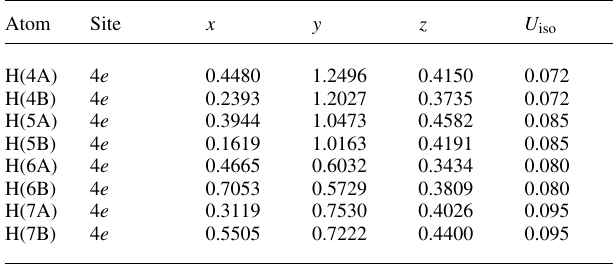
Table 2. Atomic coordinates and displacement parameters (in Å 2 )